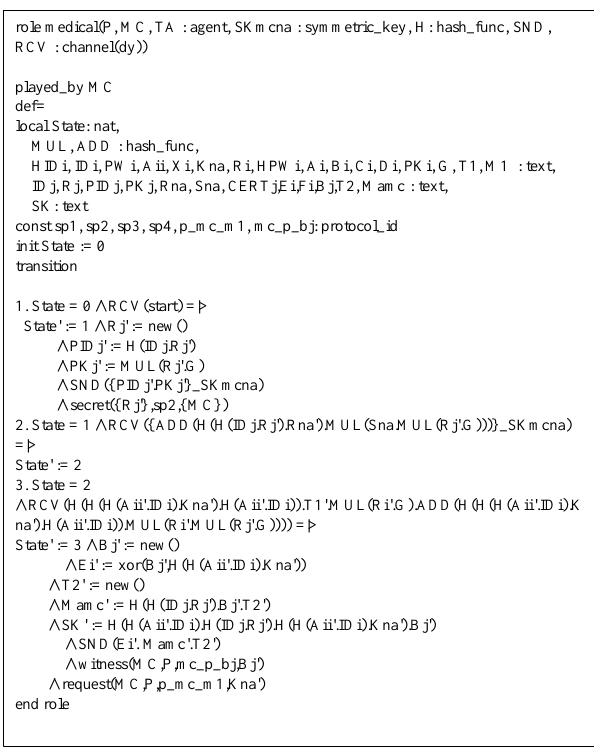
Figure 9. High-Level Protocol Specification Language (HLPSL) syntax of patient.